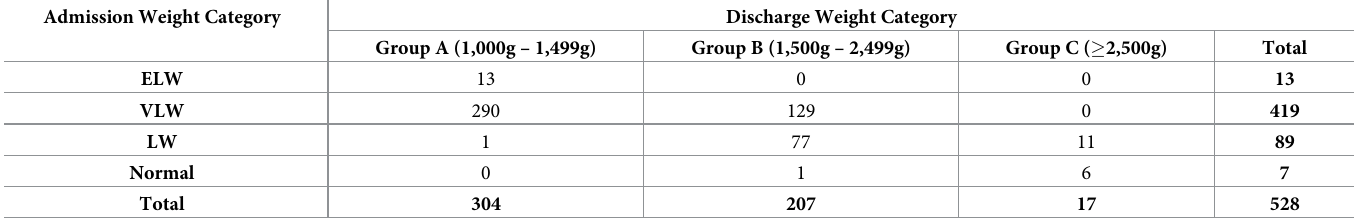
Table 3. Weight categories among neonates upon KMC admission and discharge. Admission Weight